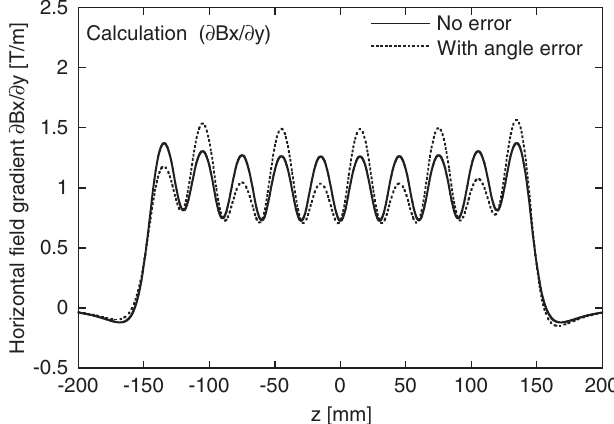
=@y ) at x ¼ 0 calcu- x ¼ 5 : 0 mrad ; (cid:1) ¼ x x